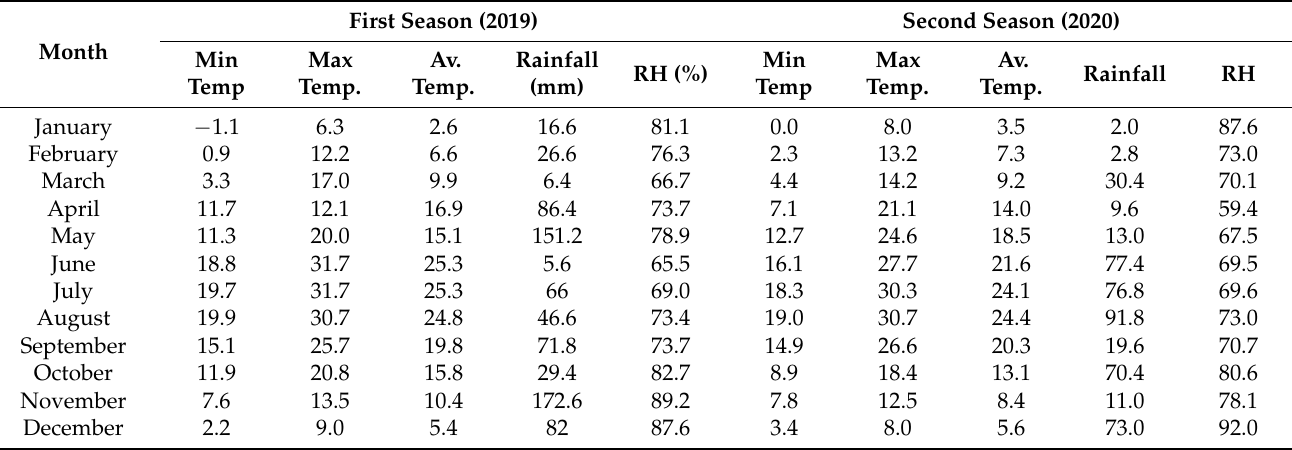
Table 5. Weather parameters during field trials at Rovigo. Rainfall is expressed as millimeters per day (mm/day), Relative Humidity (RH) is expressed as